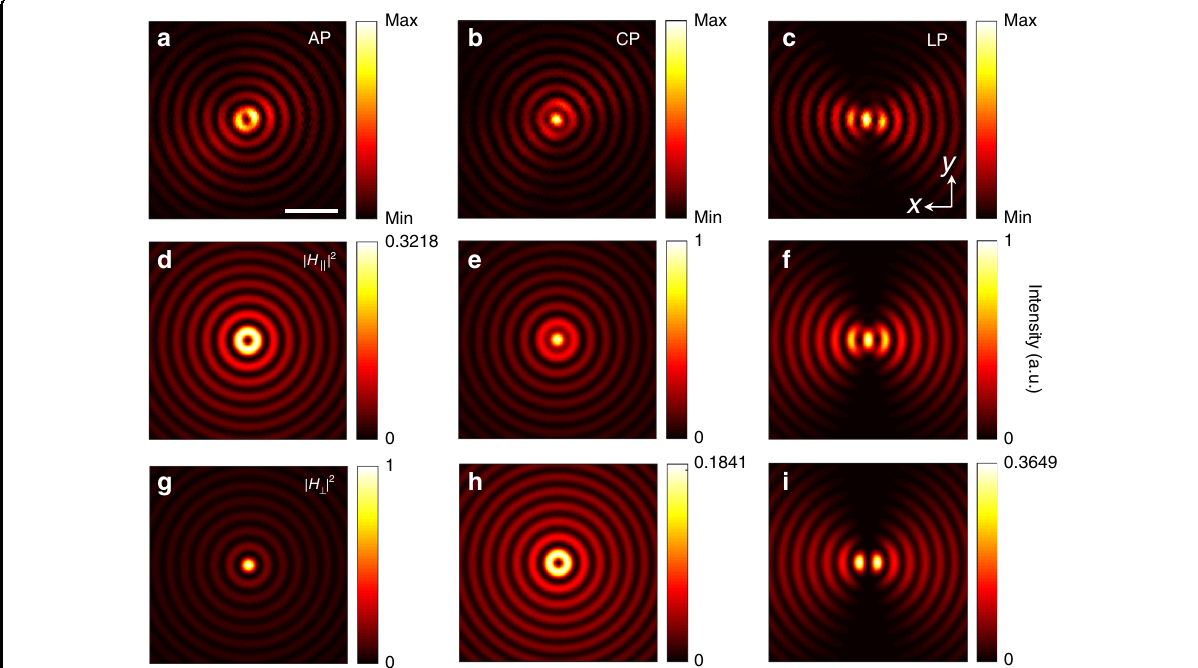
Fig. 4 Mapping the in-plane magnetic near fi elds. a – c mapped intensity distributions of various TE-type waveguide modes excited by the different incident polarized beams — from left to right, azimuthally polarized (AP), circularly polarized (CP), and linearly polarized (LP) beams; d – i calculated in-plane ( d – f ) and out-of-plane ( g – i ) magnetic fi eld component distributions. The experimental results indicate the in-plane magnetic fi eld sensitivity of the anapole probe. The scalar bar in a is 1 μ m; all images have the same